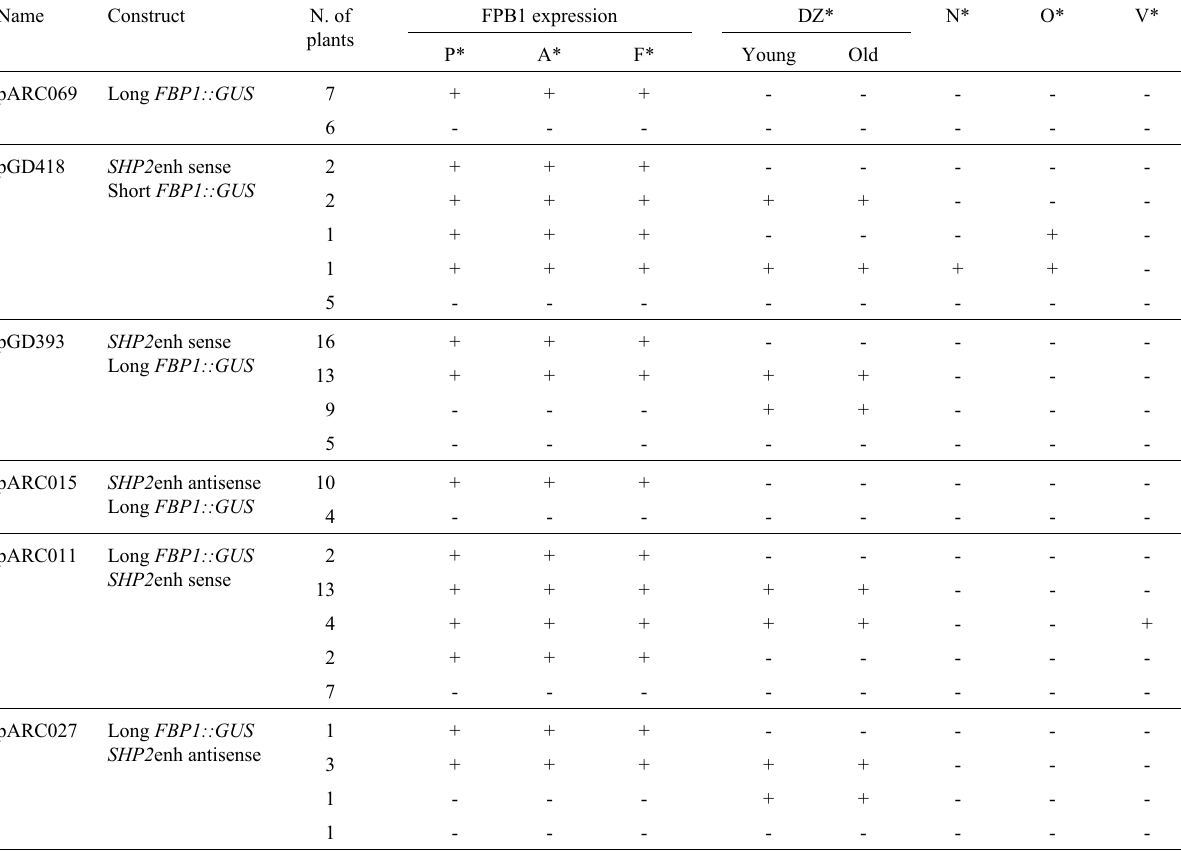
Table 2 - GUS expression observed in tissues of transgenic Arabidopsis plants containing different constructs (see Figure